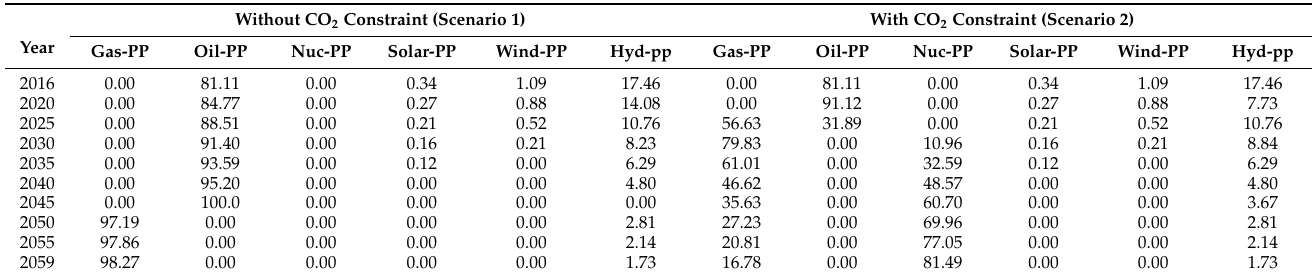
Table 7. Percentage (%) contribution of electricity from each power plant with and without CO 2